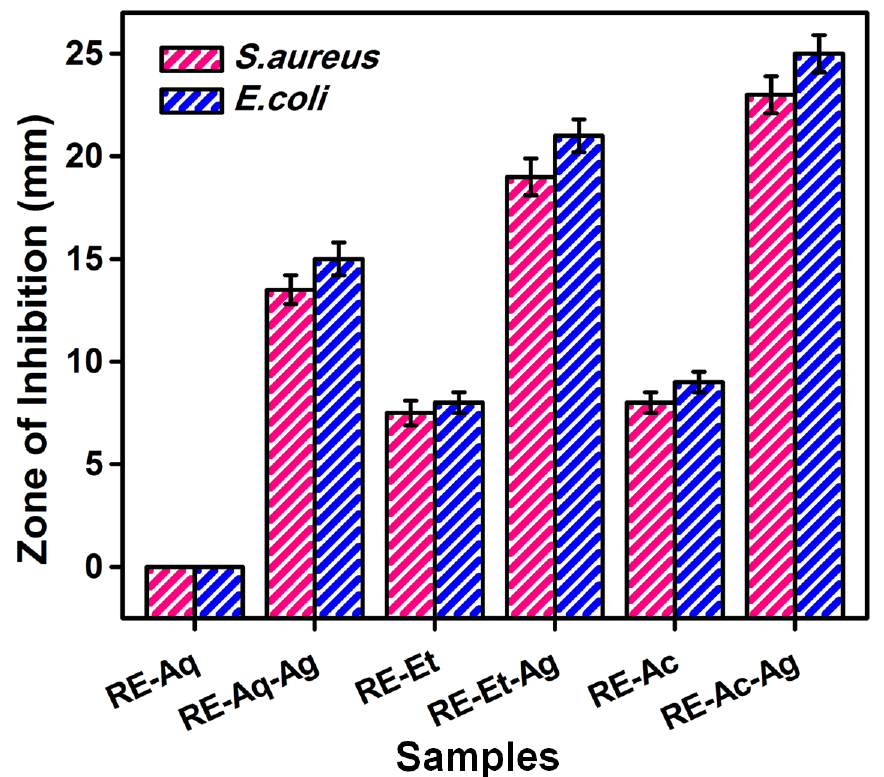
Figure 4. Antibacterial activities of Rosa indica L. pedal extracts and silver nanoparticles (values with mean + SD, n = 3).